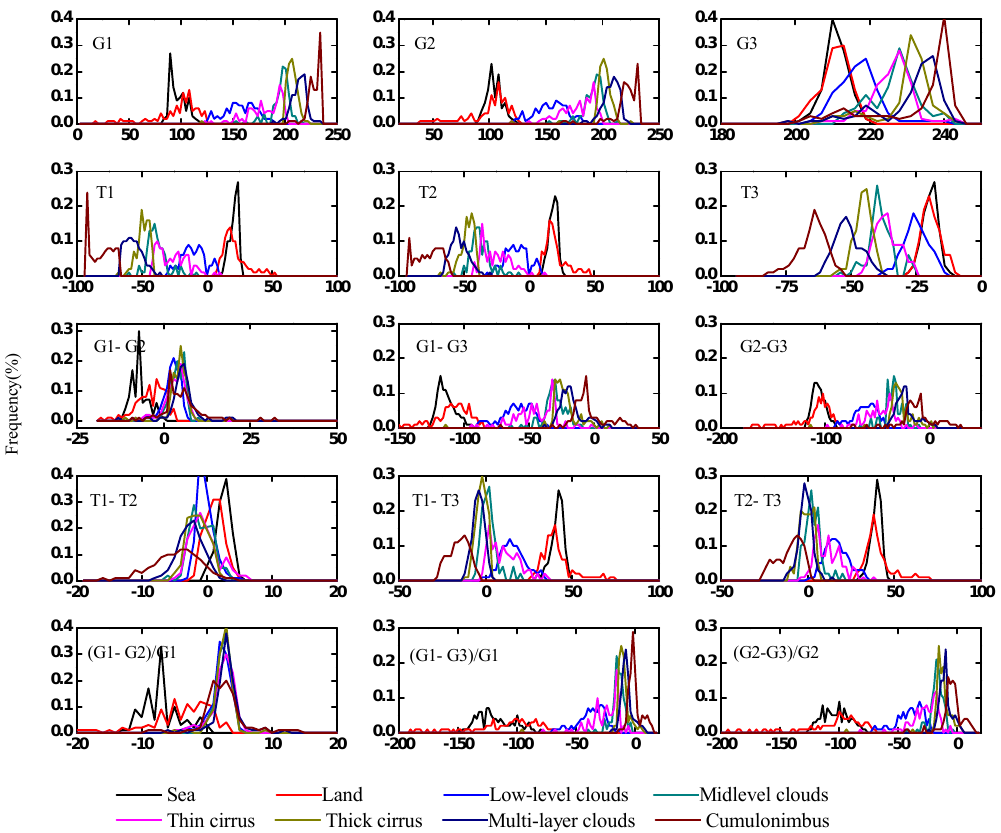
Figure 1. The frequency distribution of features of FY-2C cloud